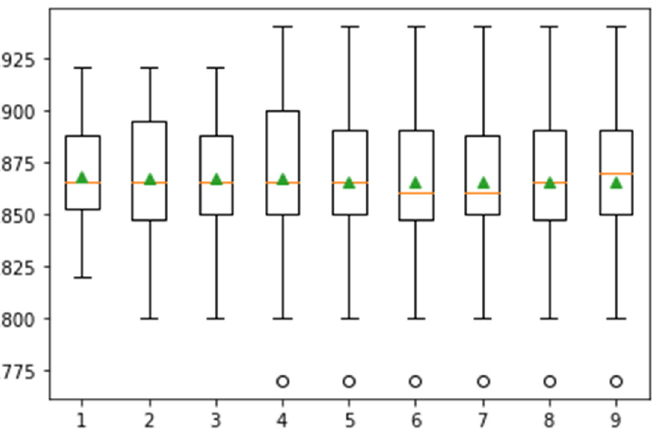
Figure 9. Confidence interval of classification accuracy by performing Monte Carlo simulation on 10-fold cross-validation using Messidor dataset.